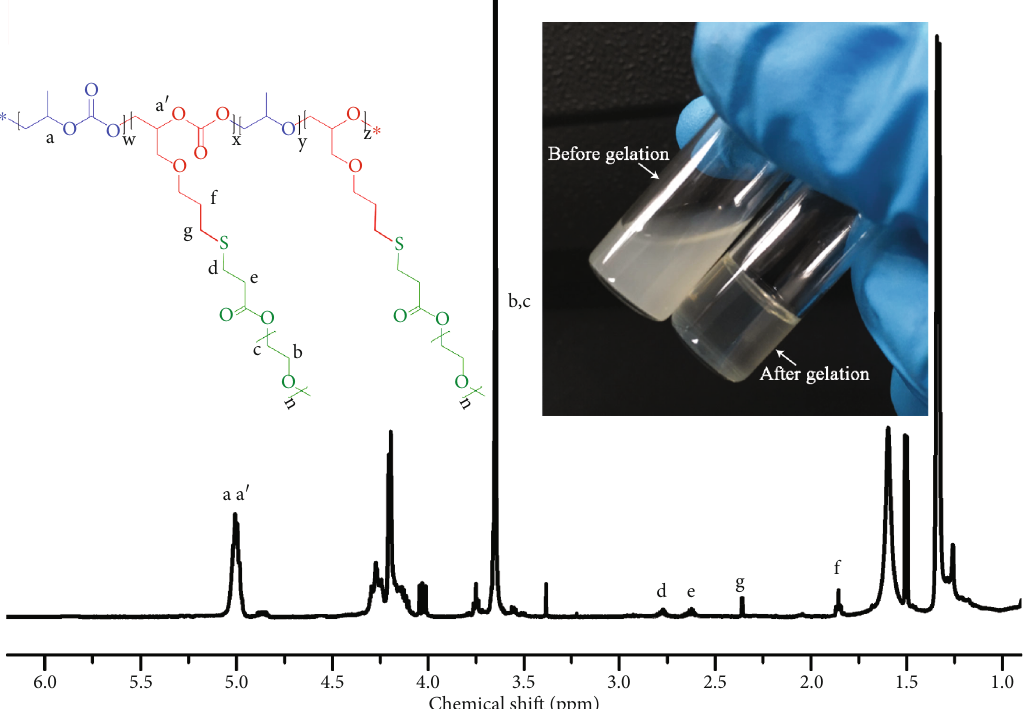
Figure 3: 1 H-NMR spectrum of PPCAGE-g-mPEG with inserting photo of the polymer solution before and after